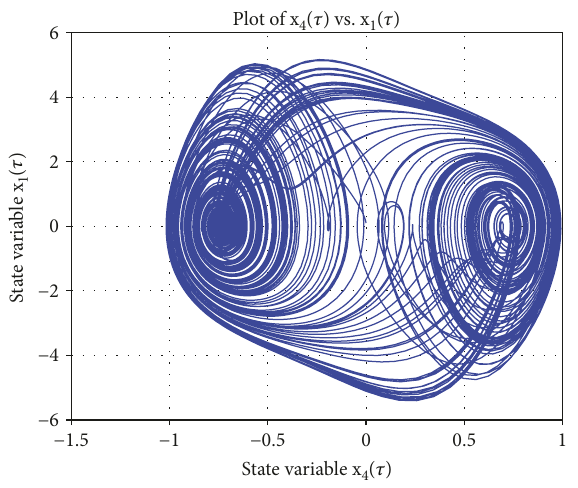
Figure 2: The chaotic attractors of system (3) with f x arctan x τ . 4